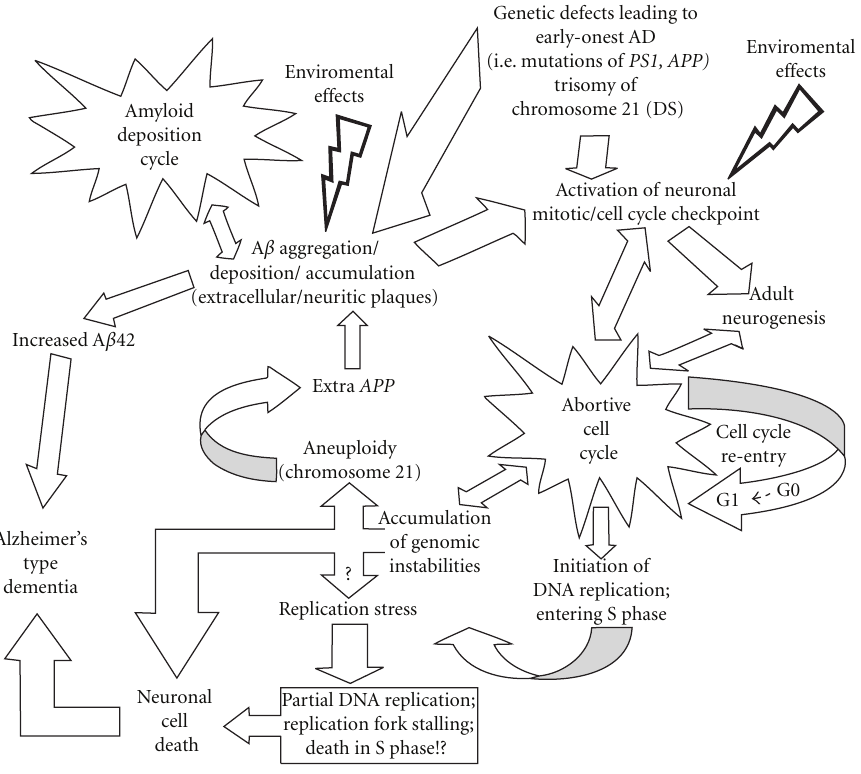
FIGURE 2: The DNA replication stress hypothesis of AD. Interplay between essential elements of the AD- type dementia pathogenetic cascade is proposed. The genetic influences ( PSEN or APP mutations, trisomy 21, APOE4 genotype), metabolic changes, and environmental factors affecting neuronal homeostasis in the aging brain lead to activation of neuronal proliferation. Mitogens, which do exist in the human brain (neuronal cells), induce additional stimuli of extensive adult neurogenesis in the hippocampus. In the AD brain, such events would lead to increased hippocampal neurogenesis. A side effect could be that these mitogenic stimuli activate cell cycle reentry in postmitotic neurons. The latter is a pathological activation of neuronal cell cycle, including reentry into G1 and S phases and initiation of DNA replication. Neurons showing protein markers of G2/M phase, probably, contain chromosome set of 23 duplicated chromosome pairs with unseparated chromatids (DNA content—4C; chromosome complement: 2N) and become tetraploid in a sense of DNA content (4C). According to the commonly accepted theory of neuronal cell cycle reentry and death, some neuronal populations complete the DNA synthesis but are arrested during the G2/M transition. Therefore, neuronal death occurs in G2 phase. Alternatively, one can propose that a large proportion of activated postmitotic neurons in the AD brain are unable to pass properly the S phase. This would lead to accumulation of genomic and chromosomal instabilities throughout ontogeny (DNA breaks, aneuploidy). In addition, replication-induced DNA damages would lead to fork stalling, incomplete or inefficient DNA replication, together designated as replication stress. Replication stress may be considered the leading cause of neuronal cell death due to processing into S phase or accumulation of genetic instabilities, which together constitute an important element of the AD pathogenetic cascade. According to the present hypothesis, the possibility to link the two main pathways of AD arises from the introduction of accumulation of genomic instabilities associated with DNA replication stress, which is able to produce as neuronal cell death (replicative cell death) as chromosomal aneuploidy due to natural selection in neural cell populations probably causing extra APP in the diseased